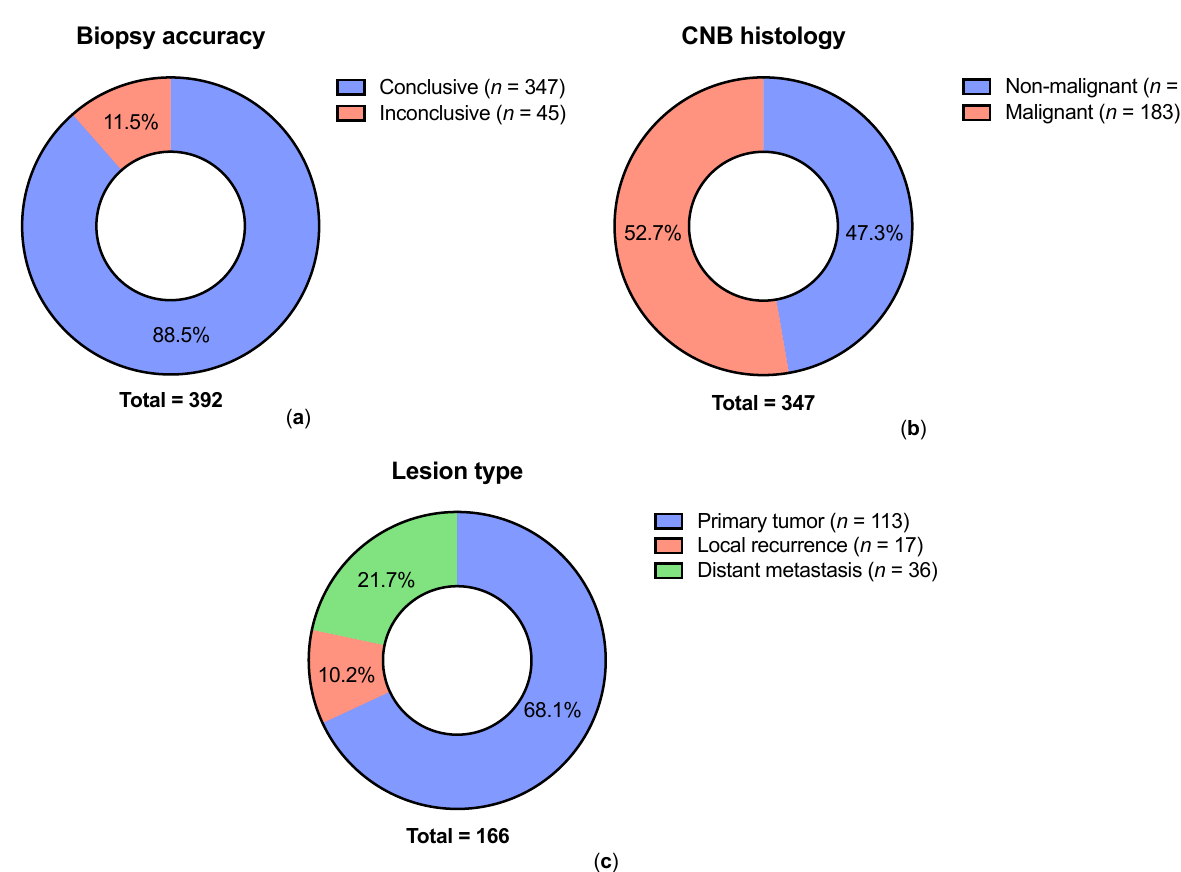
Figure 1. Results of ultrasound guided CNB for soft-tissue lesions. Accuracy ( a ), histology ( b ) and lesion type (malignant solid tumors ( c ). CNB: core needle